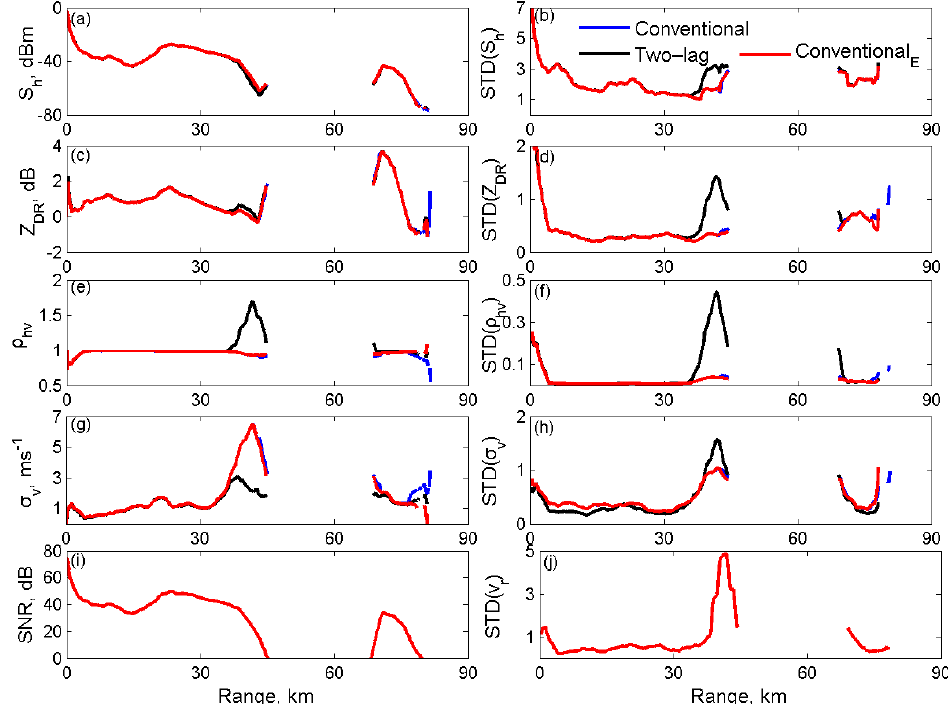
Figure 8. Comparison of conventional estimators and two-lag estimators for radial C. Four rows show S h , σ v , Z DR , ρ hv, and their standard deviation, respectively. The SNR and standard deviation of v r are given in the fifth row. ( a ) S h ; ( b ) STD(S h ); ( c ) Z DR ; ( d ) STD( Z DR ); ( e ) ρ hv ; ( f ) STD( ρ hv ); ( g ) σ v ; ( h ) STD( σ v ); ( i ) SNR; and ( j ) STD(v r ).